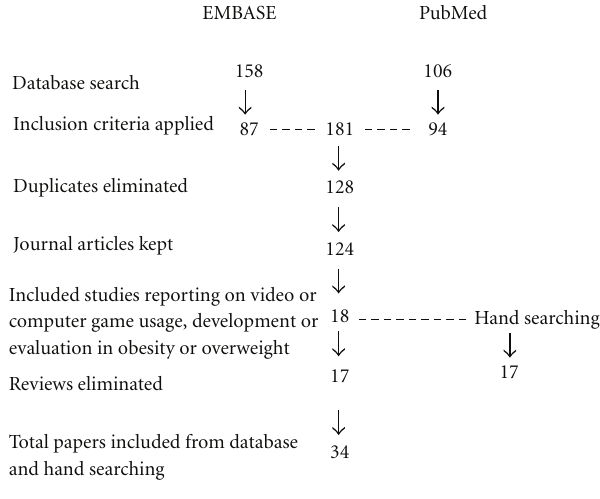
Figure 1: Identification of